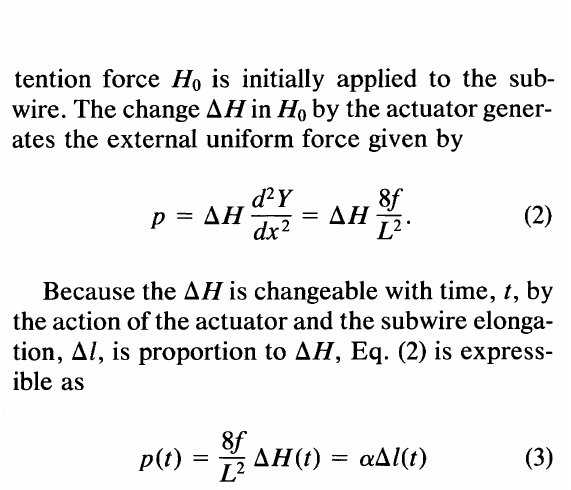
FIGURE 1 (a) A suspension bridge with a subwire; (b) an arch bridge with a